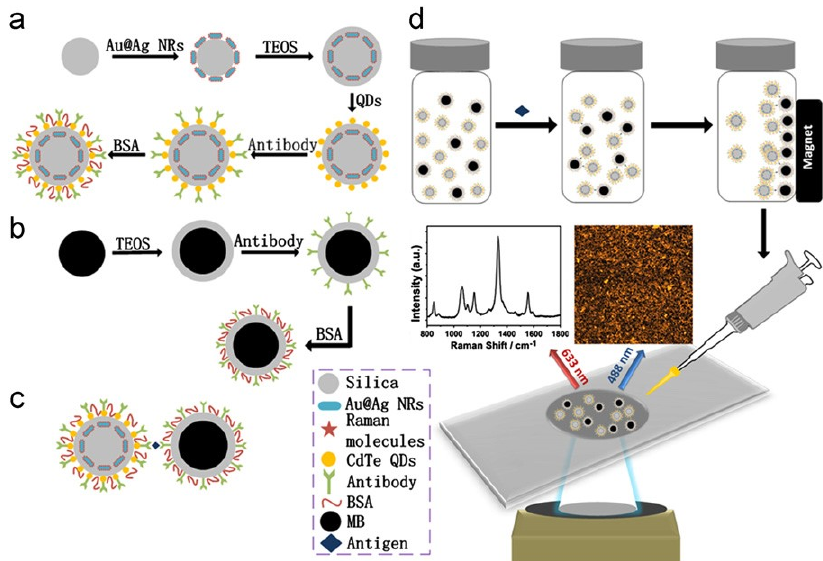
Figure 4. ( a ) Synthesis and surface functionalization procedure of the dual mode nanoprobe; ( b ) the synthesis and surface modification procedure of the magnetic beads (MBs); ( c ) illustration of the structure of the sandwich type nanocomplex formed during the immuno-reaction. For simplicity, only a single nanoprobe, antigen, and MB particle is drawn in the picture; ( d ) the aqueous phase immunoassay protocol. Reprinted [66] © 2013, with permission from Elsevier.